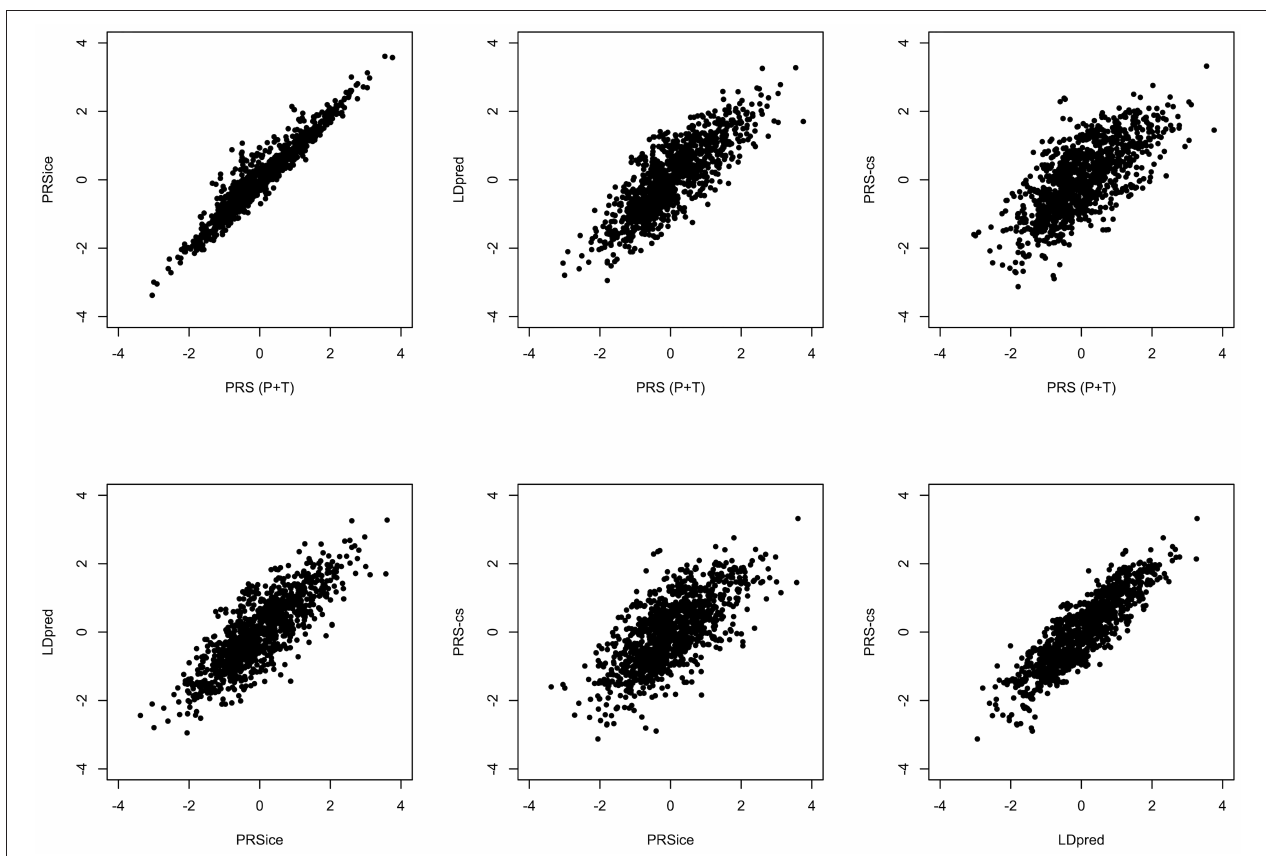
FIGURE 1 | Comparison of PRS using Different Methodologies; PRS(P + T), PRSice, PRS-CS and LDpred. The PRS is computed for all individuals in HipSci (19) open access data merged with the 1,000 Genomes data (18), scores are weighted using AD GWAS (5) summary statistics. Only SNPs with p ≤ 0.5 are included and the APOE region (chr19: 44.4-46.5Mb) is excluded for all methods.